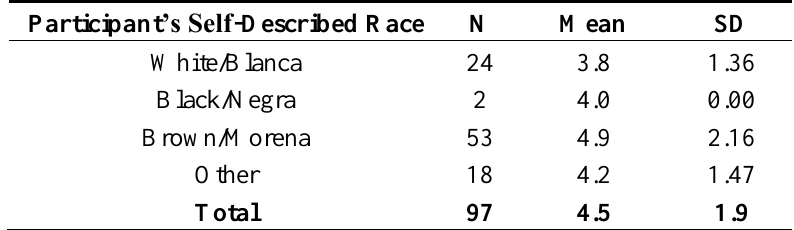
Table 4. Mean number of ethnic identifications by racial